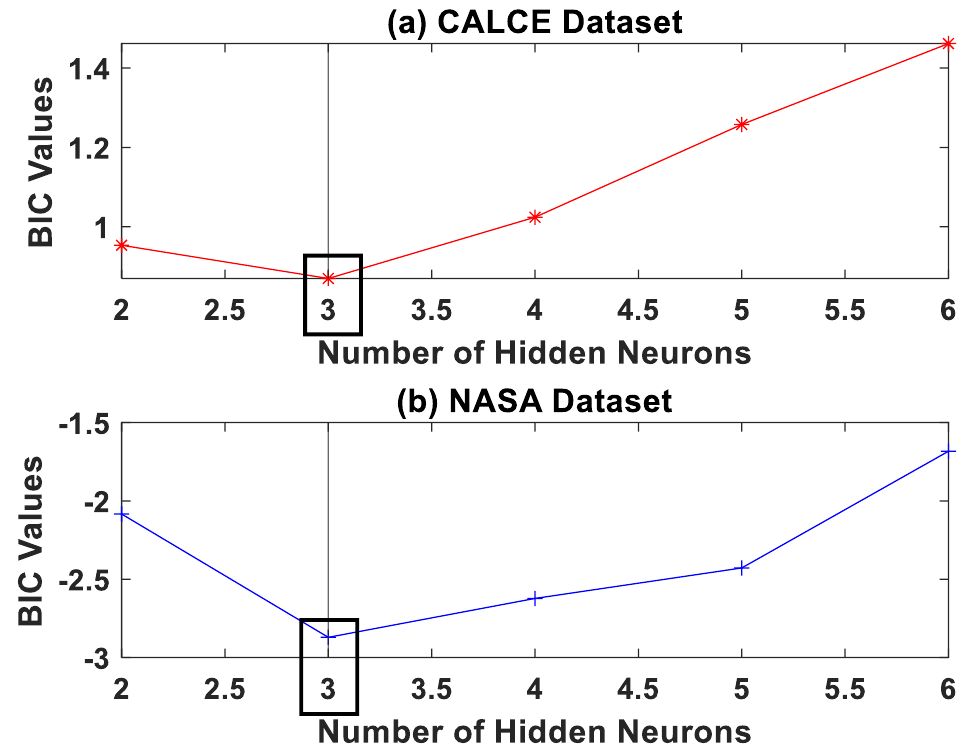
Figure 2. The BIC analysis for model selection for the two lithium-ion battery capacity degradation datasets—( a ) CALCE and ( b ) NASA datasets.